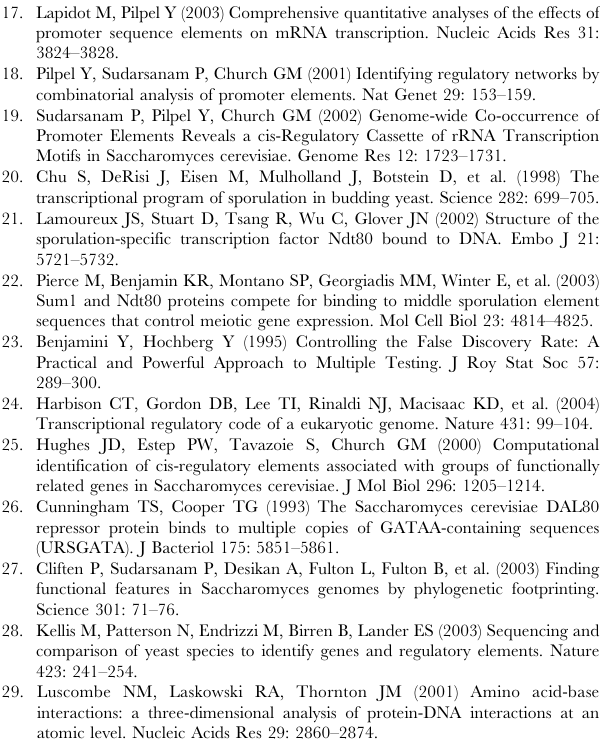
Table S3 Coverage of the Harbison motif set by our core dataset Table S4 comparison, among the different substitution types, of the distributions of p-values (corresponding to correlation coefficients) of mean expression profiles (in shared conditions) of motifs differing by a single nucleotide substitution Table S5 Comparison of the significant motif datasets obtained using the double-stranded and single-stranded methodologies Found at: doi:10.1371/journal.pgen.1000018.s014 (0.04 MB XLS) Text S1 Validation of the method of construction of the motif dataset and the comparison of this dataset to published